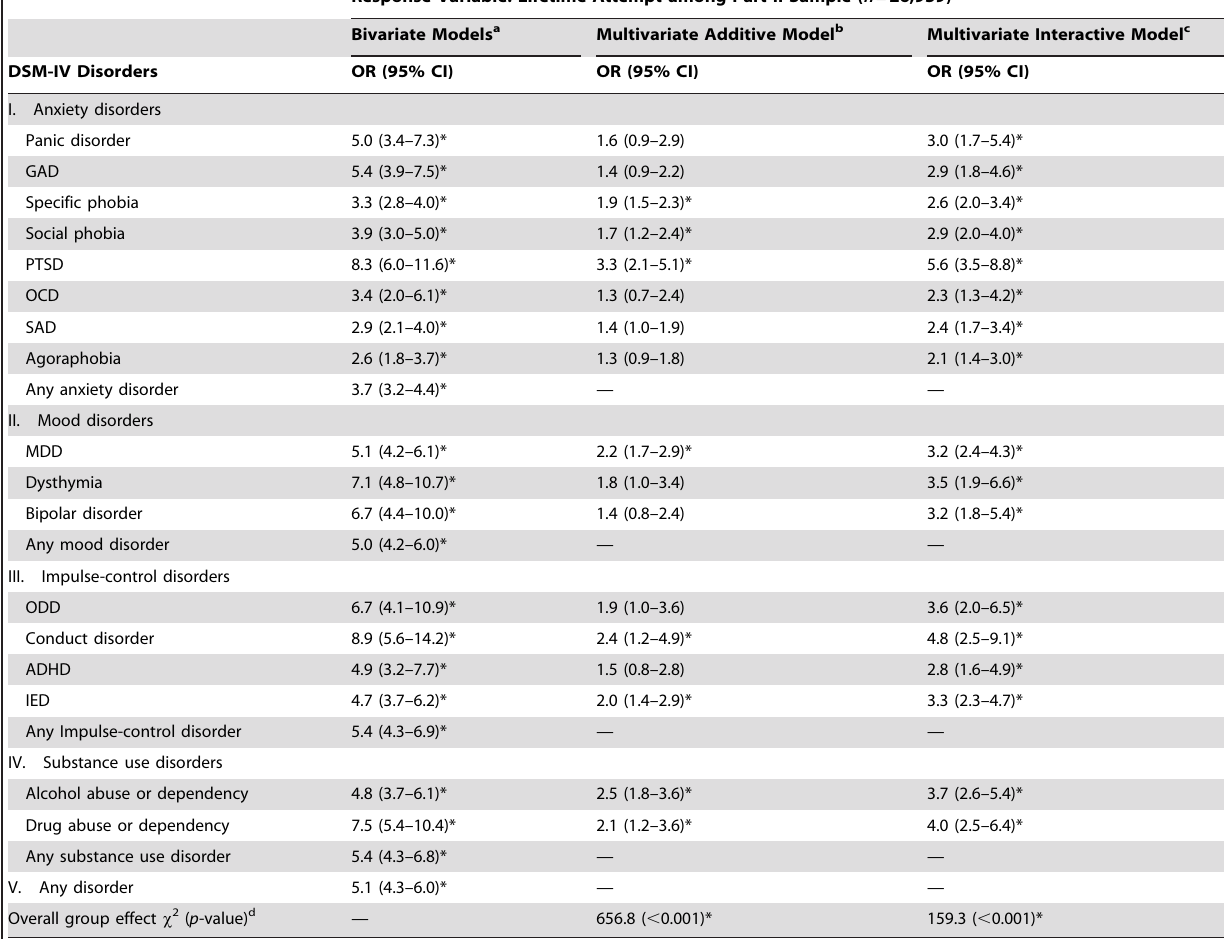
Table 3. Survival models of the associations between DSM-IV disorders and a subsequent suicide attempt—developing